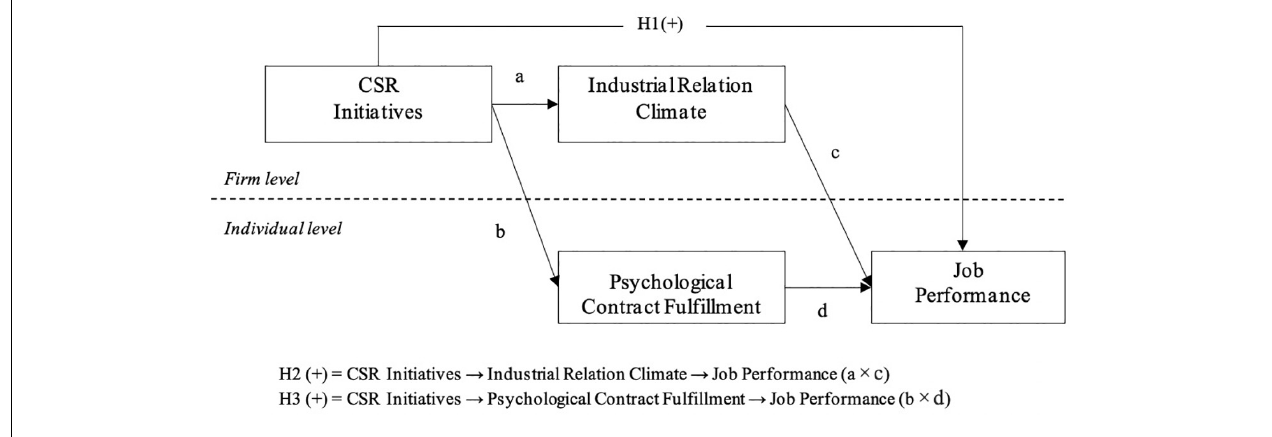
FIGURE 1 | Conceptual